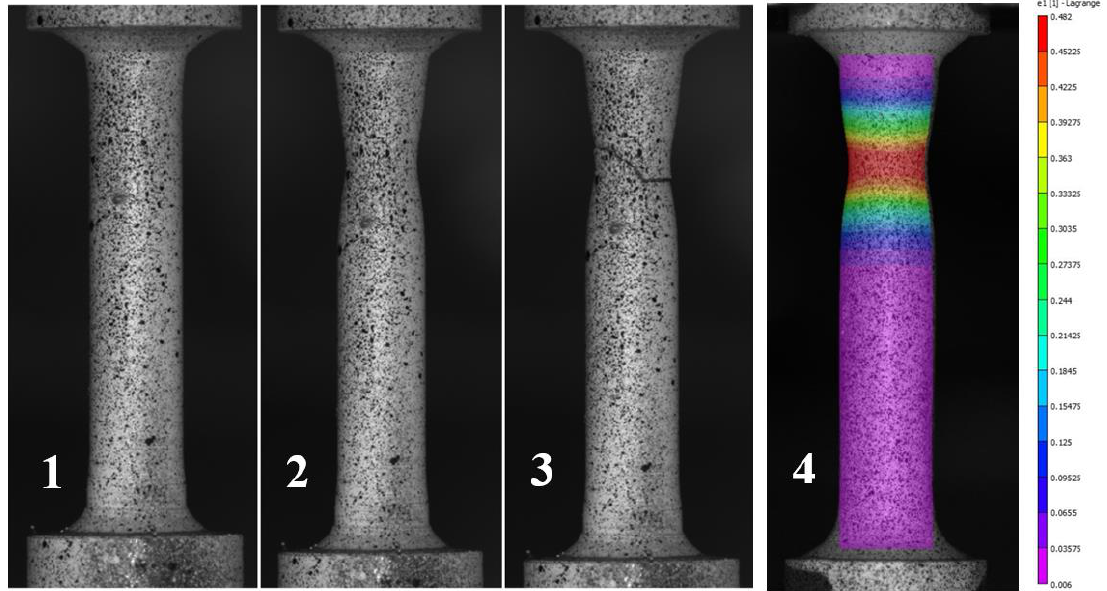
Figure 5. “O1” specimen under tension test. ( 1 ) Specimen before testing, ( 2 ) necking prior to fracture, ( 3 ) specimen post fracture, and ( 4 ) contour plot showing the Lagrange strain localization before fracture in red (maximum stain) and purple (minimum strain).